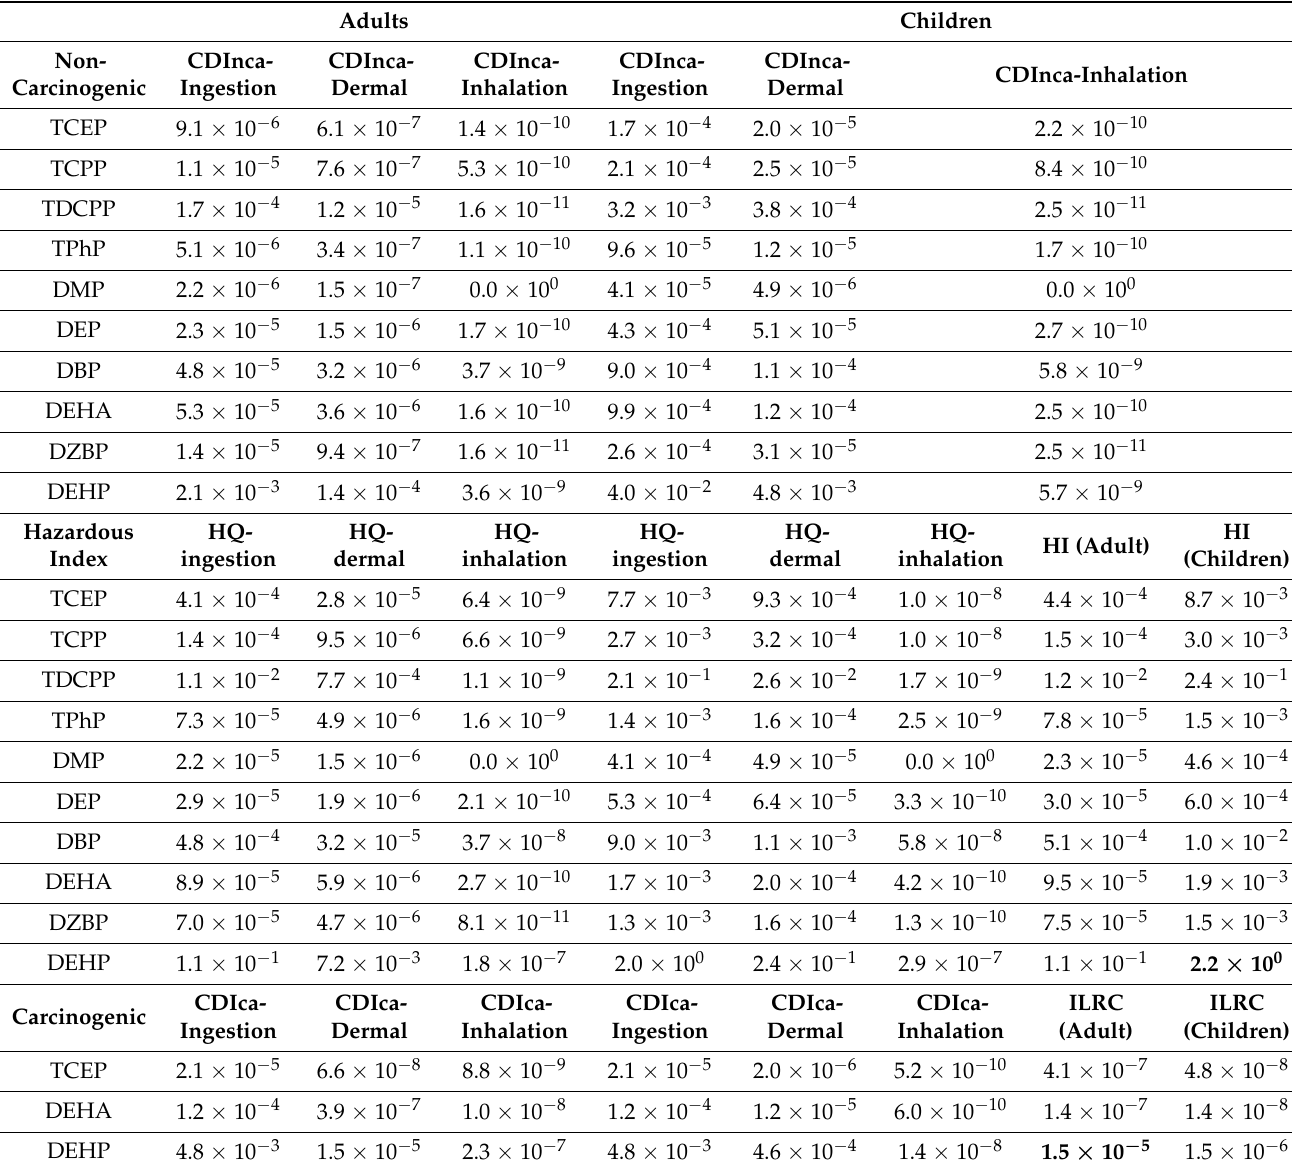
Table 5. Incremental lifetime cancer risk (ILCR) calculated using 90th percentile values of OPEs and phthalates in indoor dust for Saudi young children and adults from their